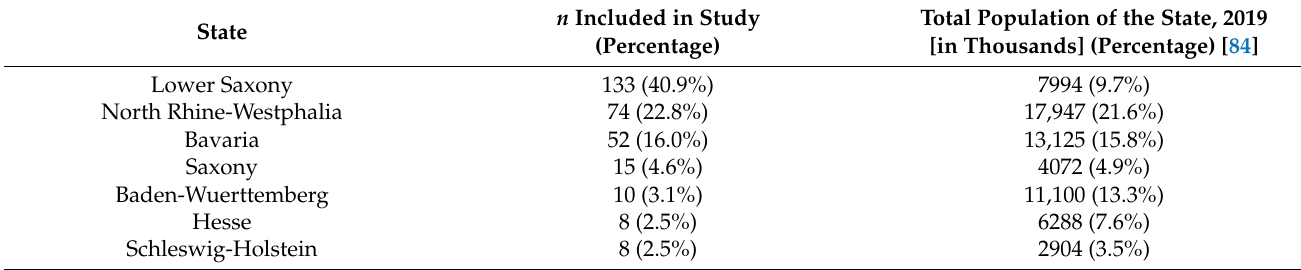
Table 2. Regional distribution of ALS patients included in this study compared with the regional distribution by state of the general population in Germany. The distribution of our patients roughly matches the regional population distribution by state in Germany. Due to rounding, percent do not add up to exactly 100. Abbreviations: ALS, amyotrophic lateral sclerosis; n ,